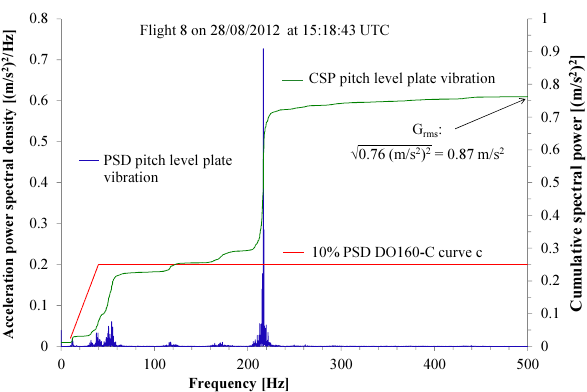
Figure 13. Vibration measurement at pitch level plate during flight 8 on HALO during chemistry mode measurement at gim- bal yaw angle of approximately 86 ◦ . Shown are the measured power spectral density (PSD) (blue) and its cumulated spectral power (CSP) (green) as well as the PSD of the assumed limit of 10% DO-160C curve c (red) for single vibration peaks.